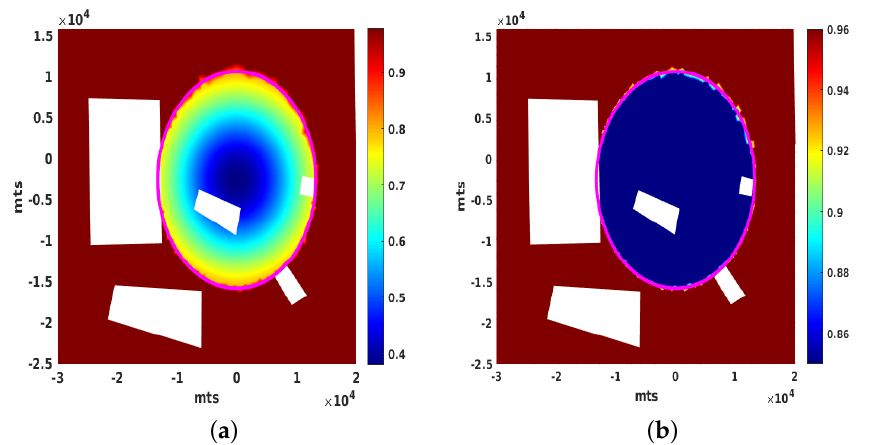
Figure 3. Examples of parameter distribution on the urban–rural domain and the urban–limit layout. ( a ) Gaussian distribution of the porosity (cid:101) with lower values at the city center and with higher values in the rural surroundings. ( b ) For dimensionless parameters such as soil emissivity e s , a simple radial distribution with only two values, corresponding to urban and rural, was assigned to each mesh